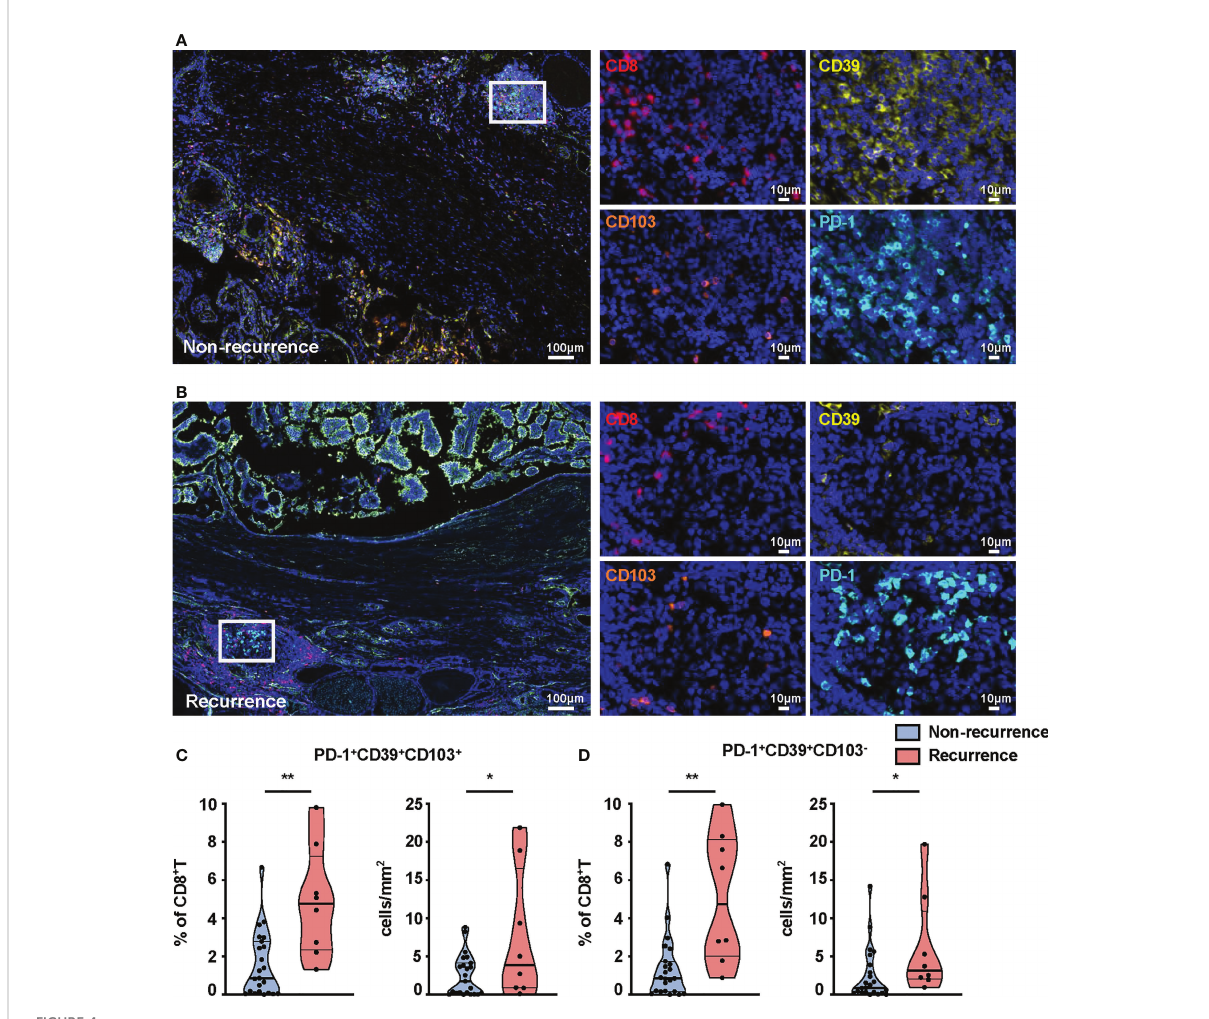
FIGURE 4 mIHC-based quanti fi cation of CD8 + T-cell subsets in tissues from non-recurrent and recurrent PTC patients. Representative immuno fl uorescence staining of CD8 (red), CD39 (yellow), CD103 (orange), and PD-1 (cyan) in non-recurrent (A) and recurrent PTC tissues (B) . DAPI staining is shown in blue. Scale bar, 100 m m, 10 m m. Frequencies (C) and density (D) of PD-1 + CD39 + CD103 + CD8 + T cells and PD- 1 + CD39 + CD103 - CD8 + T cells in non-recurrent PTC tissues (n = 23) and recurrent PTC tissues (n = 8). (Density: total PD- 1 + CD39 + CD103 + CD8 + T- and PD-1 + CD39 + CD103 - CD8 + T-cell numbers divided by area of tissue per paraf fi n sections). Data presented as mean ± SEM. *p < 0.05; **p <